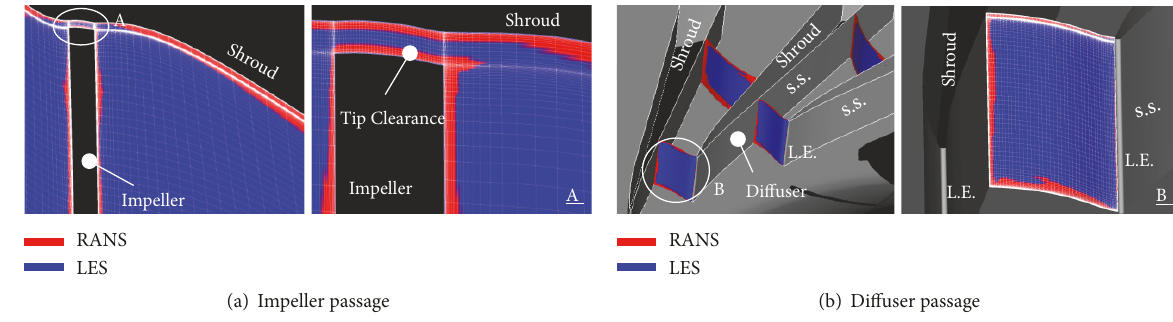
Figure 2: RANS/LES region within impeller and diffuser